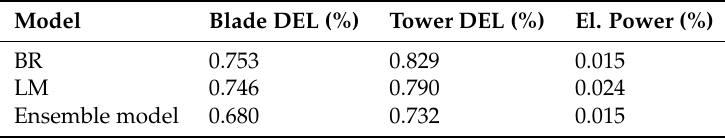
Table 3. Normalised MAE of the surrogate